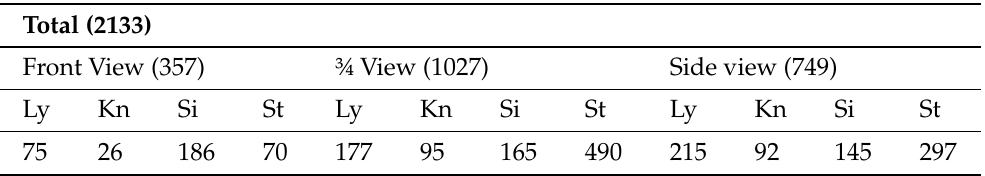
Table 1. Number of videos in each category. Subcategories are: lying down (LY); on the knees (Kn); sitting (Si); standing (St).